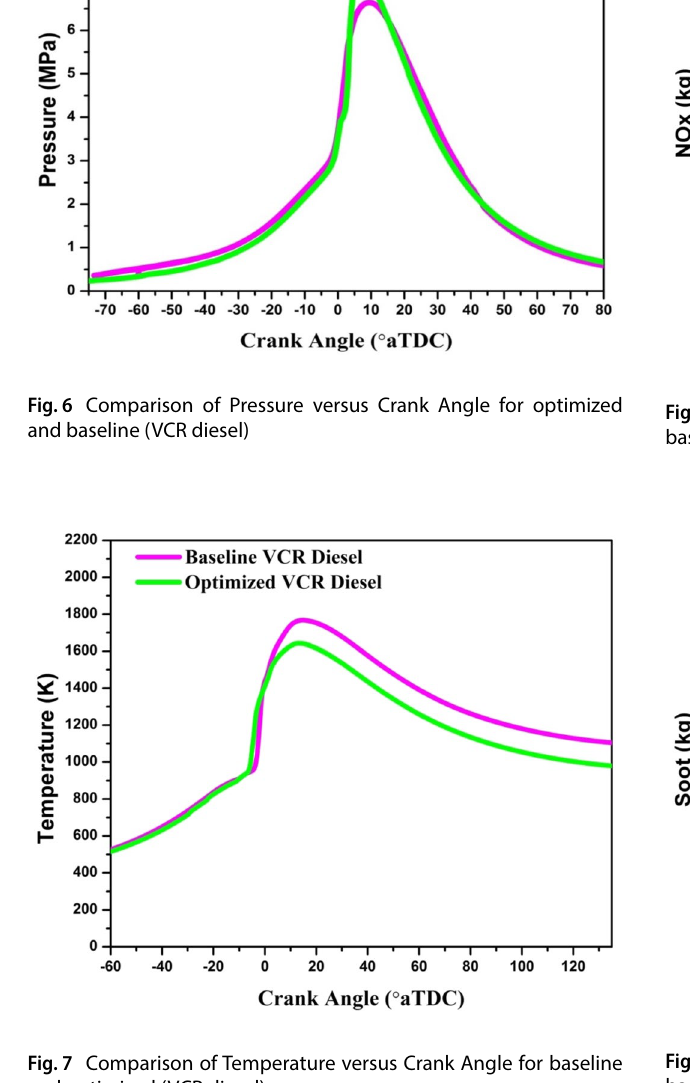
Fig. 7 Comparison of Temperature versus Crank Angle for baseline and optimized (VCR diesel)